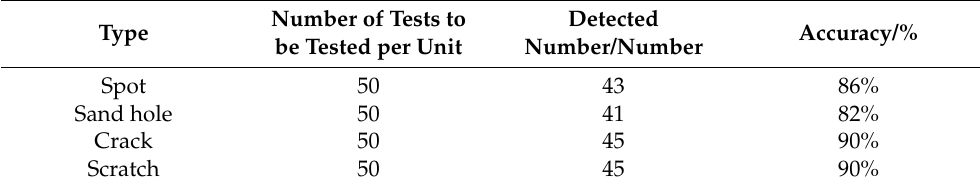
Table 5. The recognition accuracy of the log-Gabor feature extraction.